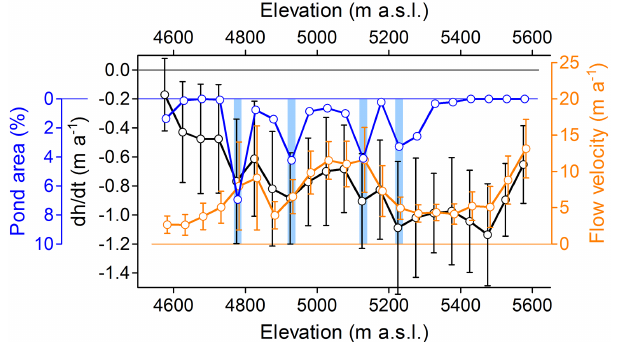
Figure 6. Elevation profiles of the change in the rate of elevation change (d h/ d t , black), ice-flow velocity (orange), and supraglacial pond area fraction (blue) at 50m elevation bands over the debris- covered area of Kanchenjunga Glacier. The light blue bars denote the peaks in supraglacial pond area fraction mentioned in the main